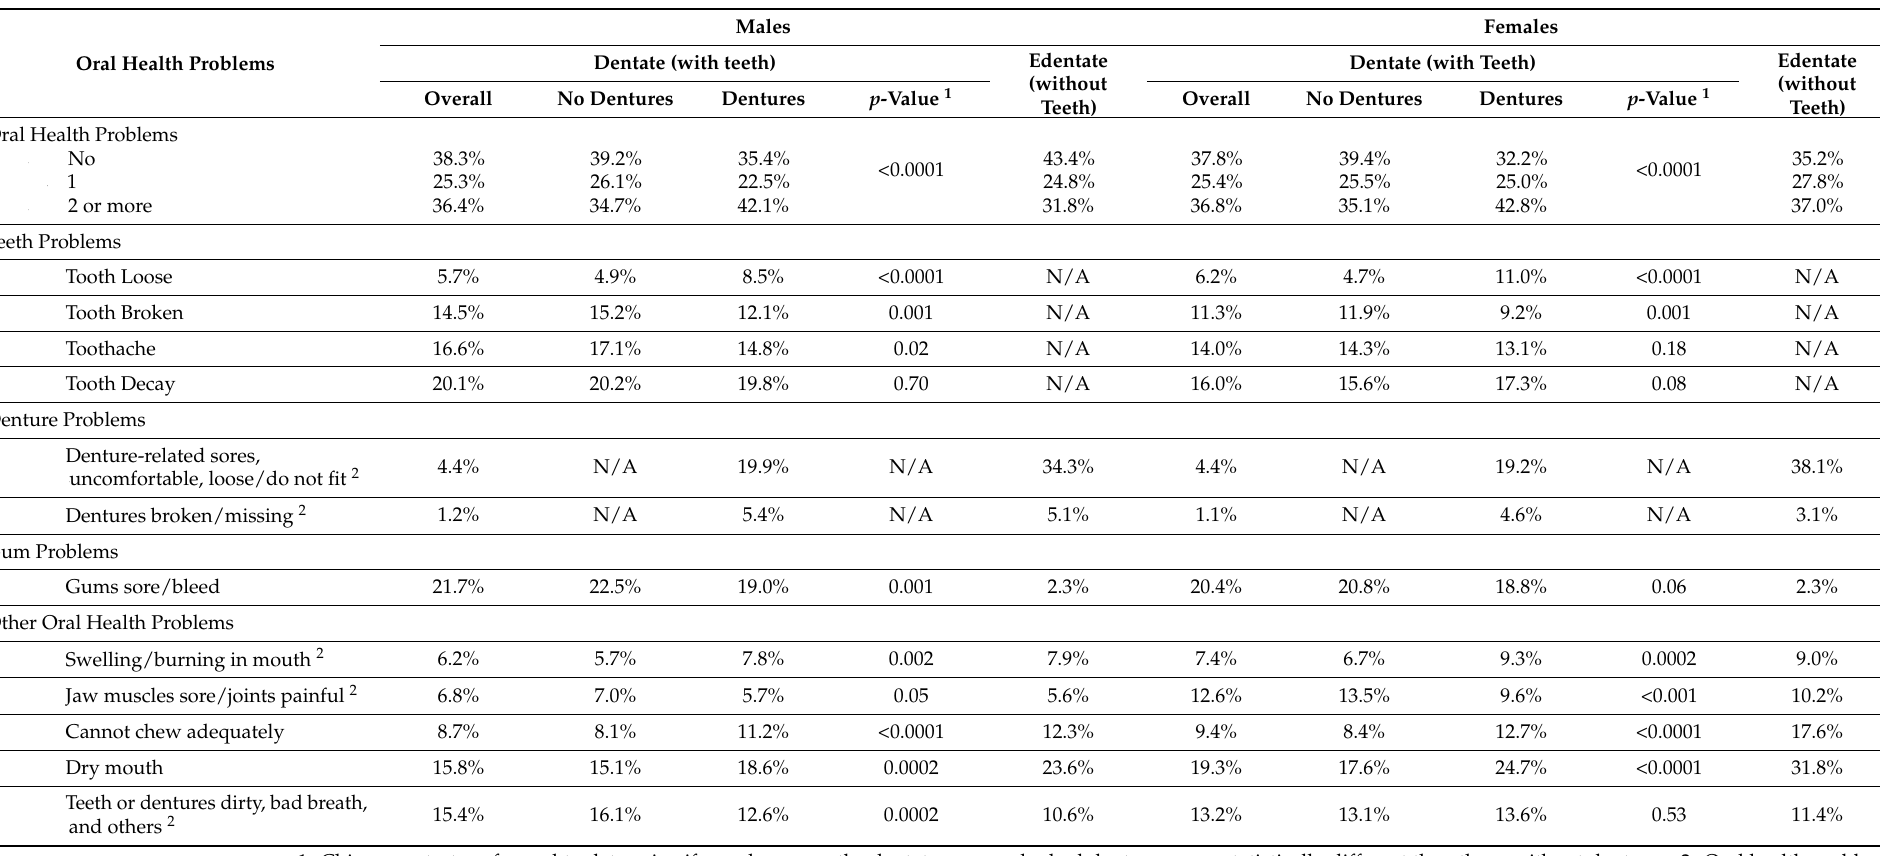
Table 2. Percentage of oral health problems among males and females from the Canadian Longitudinal Study on Aging (CLSA) at CLSA baseline (2011-2015), by teeth status.